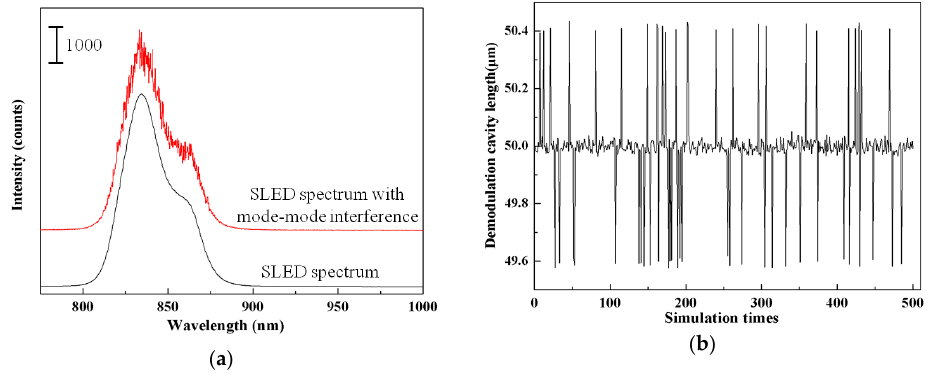
Figure 9. ( a ) Output of SM-MM SLED spectrum and SM SLED Spectrum, ( b ) the 500-times simulation result of demodulated F-P cavity length with random mode-mode interference.